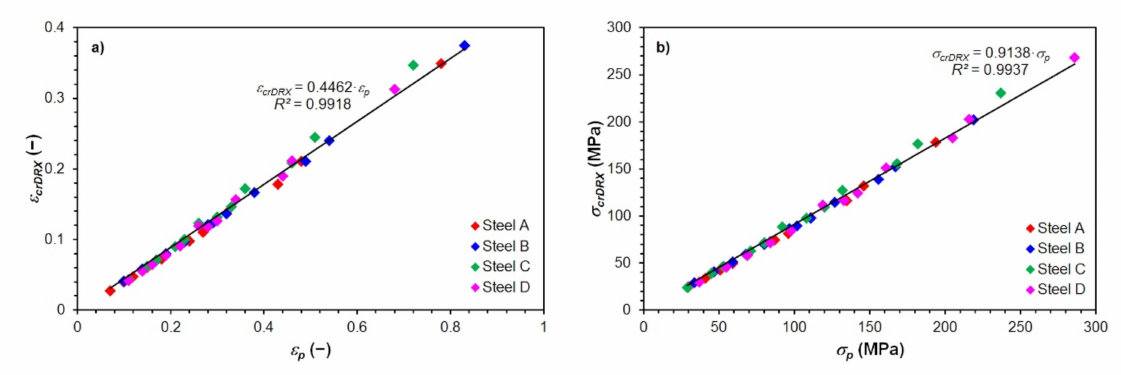
Figure 16. Dependence of the critical strain ε crDRX and the critical flow stress σ crDRX on the corre- sponding coordinates of the peak stress of all investigated steels: ( a ) critical strain ε crDRX ; ( b ) critical flow stress σ crDRX